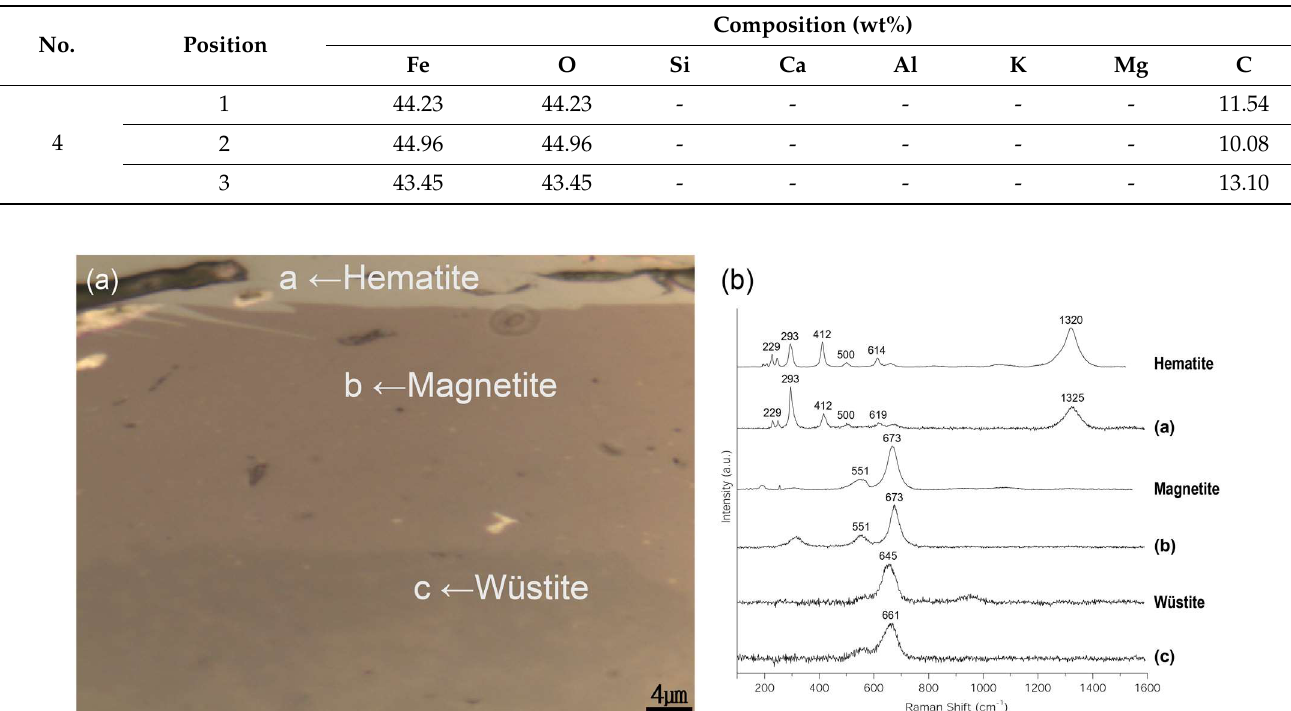
Figure 11. Microstructure and SEM image of flake hammer scale (No. 4): ( a ) whole image, ( b ) metal- lographic microscope detailed image and rectangle is position of the SEM analysisdetailed image and position of SEM analysis, ( c ) position of SEM image and EDS analysis; 1: hematite, 2: magnetite, 3: wüstite. Table 5. EDS analysis of flake hammer scale (No. 4).